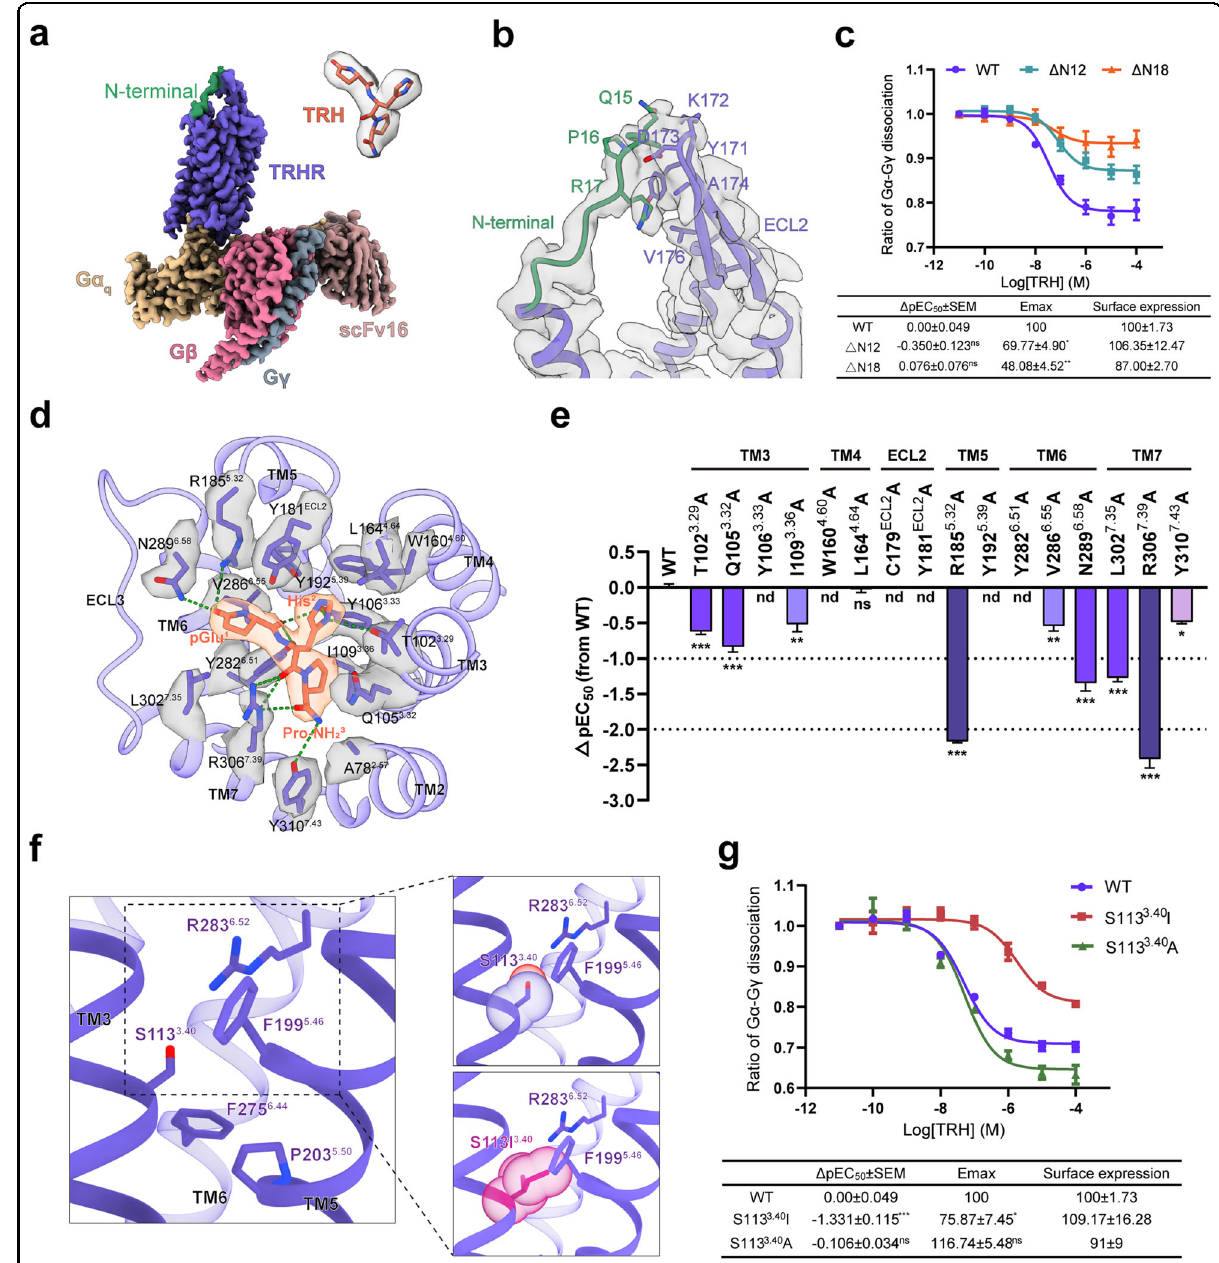
Fig. 1 Ligand recognition and activation of human TRHR. a Cryo-EM structure of the TRH-bound TRHR – G q complex. The density of TRH is shown. TRHR, slate blue; G α q , burly wood; G β , pale violet red; G γ , light slate gray; scFv16, rosy brown. The resolved N-terminus of TRHR is highlighted in sea green. b Interactions between the extended N-terminus and ECL2 of TRHR. c Effects of the N-terminal truncations ( Δ N12 and Δ N18) on TRH-induced receptor activation. The G q dissociation signal was detected by NanoBiT assay. d Detailed interactions of TRH (orange) with TRHR (slate blue). Hydrogen bonds are depicted as green dashed lines. e Effects of mutations in TRH-binding pocket on TRH-induced G q dissociation signal as indicated by NanoBiT assay. Bars represent differences in calculated TRH potency [pEC 50 ] for representative mutants relative to the wild-type receptor (WT). Data are colored according to the extent of effect. f Close structure examination of the non-conserved S113 3.40 in the “ PIF ” motif of TRHR. Replacement of S113 3.40 with I 3.40 may form steric hindrance with the adjacent residues R283 6.52 or F199 5.46 . g The effect of S113 3.40 mutations in TRHR on TRH-induced G q dissociation signal. Data are shown as means ± SEM from at least three independent experiments performed in technical triplicate. The cell surface expression and E max values were normalized to WT TRHR. nd not determined, ns no signi fi cance. P > 0.05; * P < 0.05; ** P < 0. 01; *** P < 0.001 by one-way ANOVA followed by Dunnett ’ s multiple comparisons test, compared with